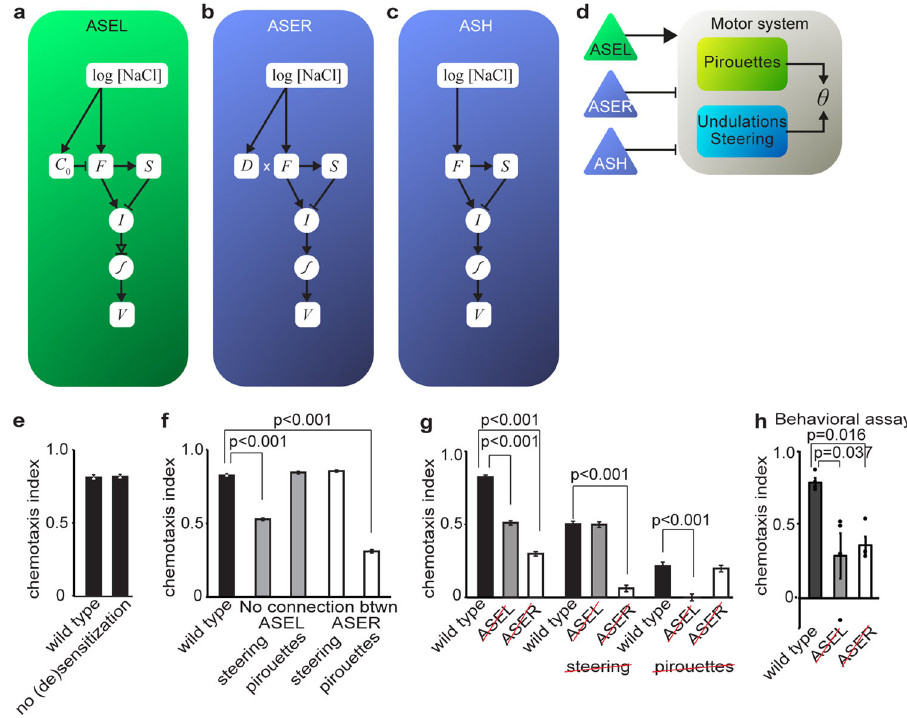
Fig. 7 Computational model reproduces sensory responses to NaCl in virtual quadrant assay. a – d Schematic of the computational model. a-c Internal sensory computation in ASEL, ASER and ASH, respectively. Sensory stimuli drive a fast component F , and a delayed recti fi er S , with opposite contributions to the overall current I . ASEL desensitization is included as an adaptive threshold C 0 , ASER sensitization is modeled using a multiplicative gain, D , and ASH sensitization is modeled as a stochastic binary switch. The current-voltage relation is given by a sigmoidal activation function. d Sensorimotor pathway modulates rhythmic undulations and the frequency of random turns. e – g Average chemotaxis index (±SEM) of model wild-type versus mutant animals in the simulated quadrant assay. e Our model shows no difference in attraction in the quadrant assay between wild-type model animals ( n = 950) and animals with always fully sensitized ASEL and ASER (no (de)sensitization, n = 934). f Ablating the synaptic connections from ASEL to the steering circuit ( n = 962 animals) or from ASER to the pirouette neuron ( n = 936) signi fi cantly reduced the chemotaxis index (Supplementary Table 2). Ablating the connection from ASER to steering ( n = 967) very slightly increased the chemotaxis index (wild type: n = 950; no connection between ASEL and pirouettes: n = 952). g Double mutants with ablated ASEL and no steering, or ablated ASER and no pirouettes achieved the same chemotaxis index as single mutants ( n = 938 – 950 animals). h Experimental validation: animals with genetically ablated ASEL (OH8585) and genetically ablated ASER (OH8593) exhibited a strong reduction in the average chemotaxis index (±SEM) in the quadrant assay ( n = 4 independent assays). Individual data points have been indicated as dots. See corresponding Supplementary Movies 1 – 14. Statistically, signi fi cant differences have been indicated, * p < 0.05, *** p < 0.0005 (non-signi fi cant differences, p > 0.05, have not been indicated). Source data underlying this fi gure are available in Supplementary Data